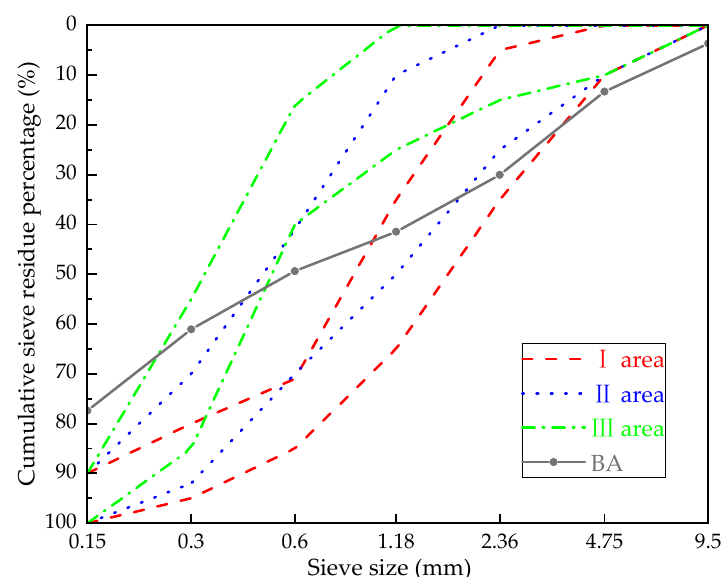
Figure 1. Screening curves of bottom ash (BA).